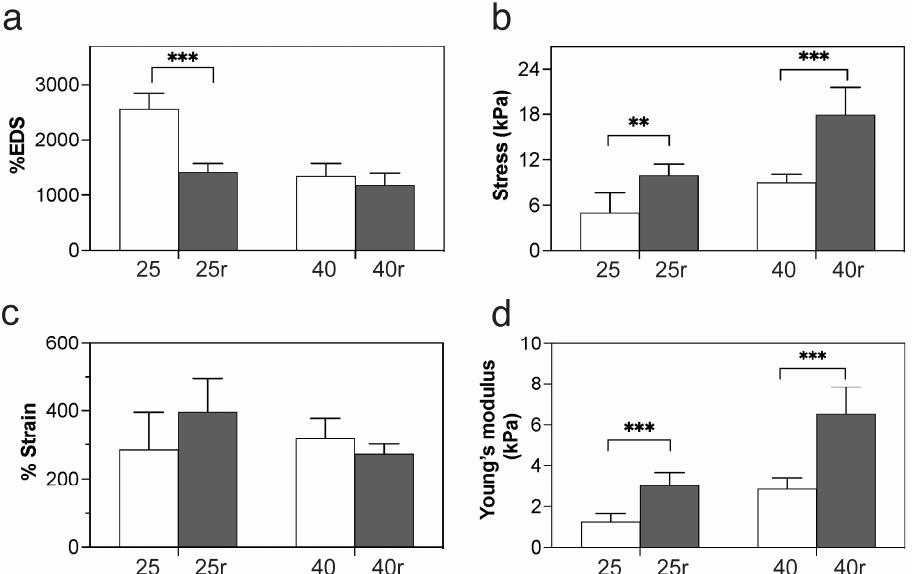
Figure 4. Effect of repeated irradiation on the ( a ) swelling, ( b ) tensile strength, ( c ) elongation at break, and ( d ) Young’s modulus of the hydrogel sheets. Symbols ** and *** correspond to p -values of less than 0.01 and 0.001, respectively.